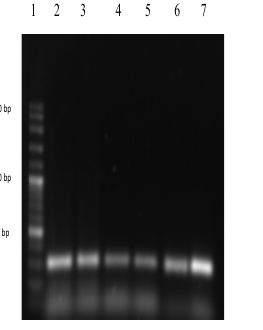
Figure 3. Lane 1 depicts marker (GeneRuler™ 100 bp Plus DNA Ladder), while lane 2, 3, and 4 shows the PCR products of type Figure 2. Lane 1 depicts marker (GeneRuler™ 100 bp